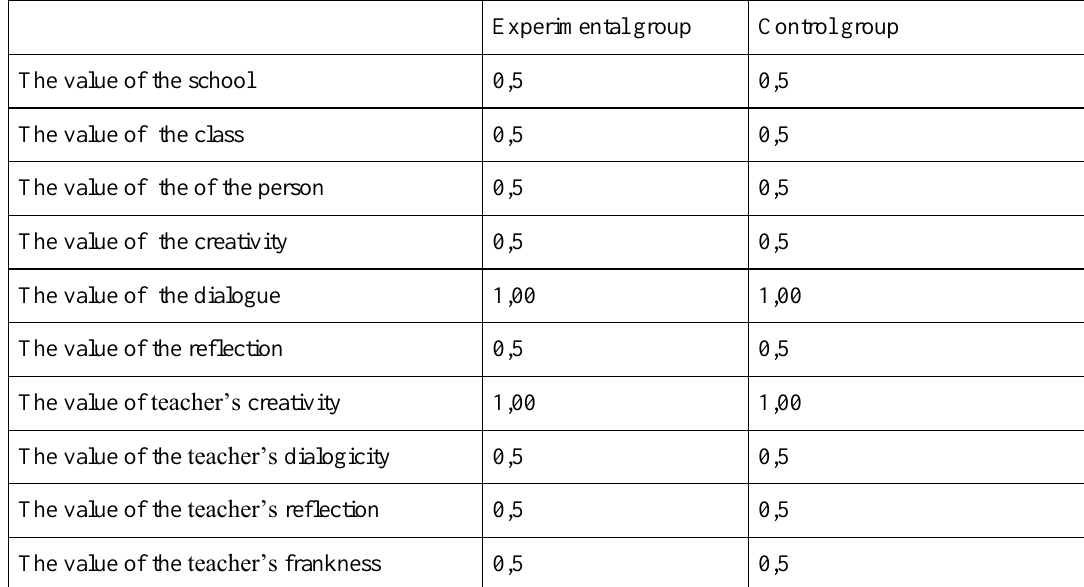
Table 2. The level of cooperation in the children's team (experimental and control groups) Experimental group Control